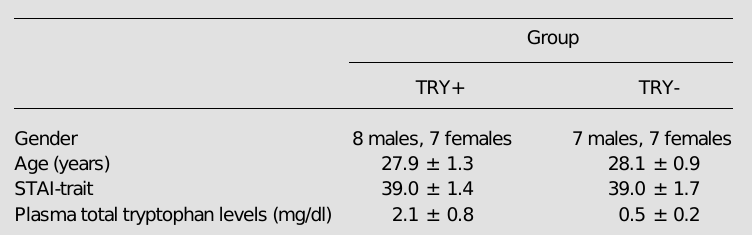
Table 1 - Characteristics of the sample. Data are reported as means ±